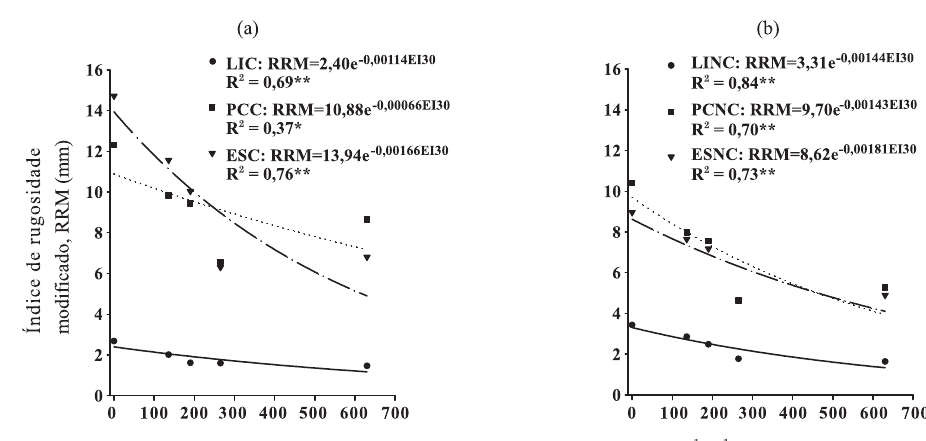
figura 3. Relação entre o índice de rugosidade superficial ao acaso modificado (RRm) e a erosividade da chuva (ei 30 ), nos tratamentos superfície quase lisa em solo compactado (lic) e não compactado (linc), aração e gradagens em solo compactado (pcc) e não compactado (pcnc) e escarificação em solo compactado (esc) e não compactado (esnc), sobre um cambissolo Húmico alumínico